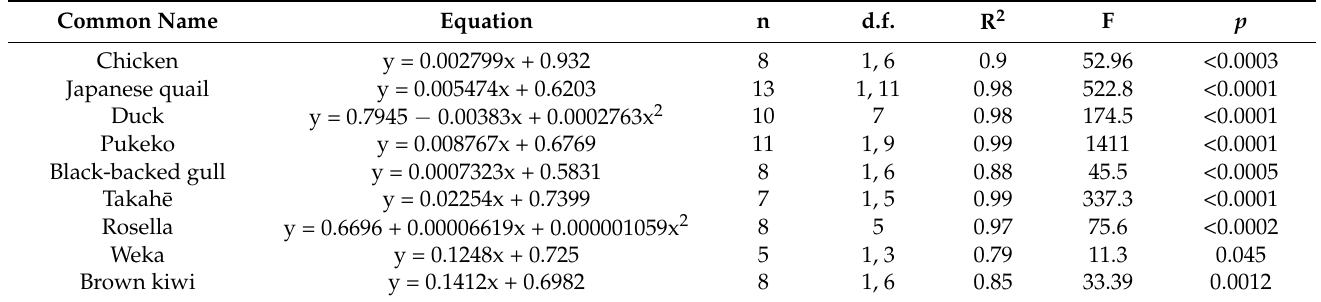
Table 1. Regression of PAPP dose (mg kg − 1 ) with the peak methaemoglobinaemia absorbance index (1/MAI) detected at either T1 or T2 for n birds together with the degrees of freedom (d.f.), R-squared value (R 2 ), F-value (F) and significance of the regression fit ( p